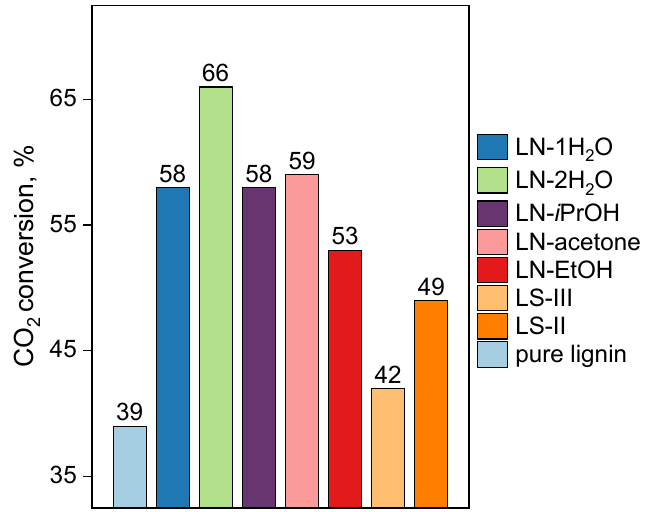
Figure 4. The results of the catalytic tests for the prepared Fe-containing materials and the starting lignin in the reaction of the conversion of lignin in the presence of CO 2 at 800 ° C.